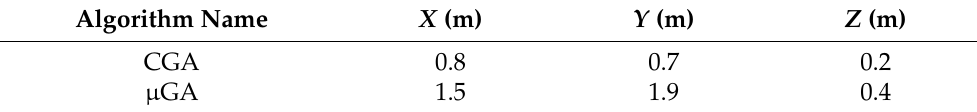
Table 7. Alignment of finding the maximum